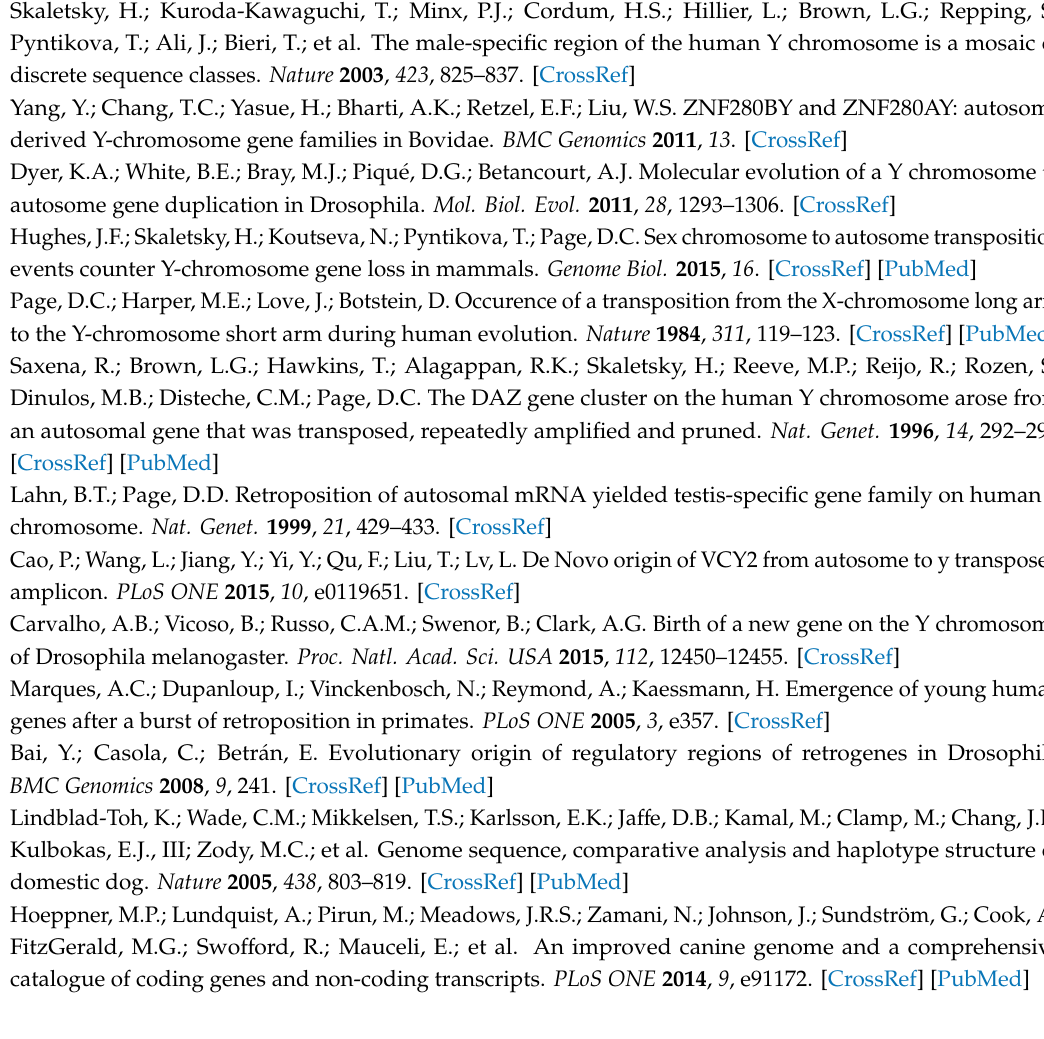
Figure S1: title, Table S1: title, Video S1: title. The following are available online: Figure S1: Alignment of MITFY and parental MITF (Chr20) sequences, the start and stop codons are bolded, Illumina SNPs are highlighted in yellow; Figure S2: Alignment of PPP2BCY and parental PPP2CB (Chr16) sequences, the start and stop codons are bolded, Illumina SNPs are highlighted in yellow; Figure S3: Alignment of WNK1 sequences: parent gene (Chr27), Y chromosome retrogene, and chrUn_AAEX03024224 retrocopy, Illumina SNPs are highlighted in yellow; Table S1: Sequence Read Archive accession numbers for resequencing data used